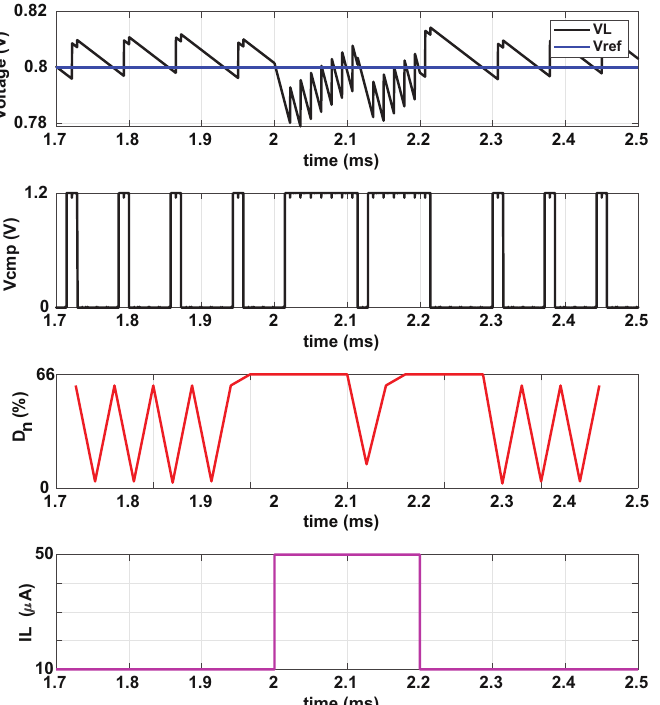
Figure 8. Transient response of the SI boost regulator at V L = 0.8 V when I L changes from 10 µ A to 50 µ